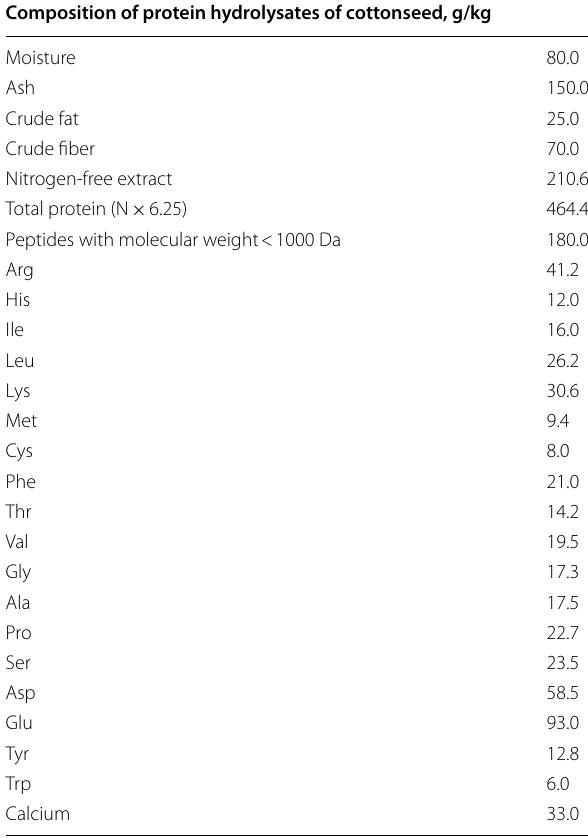
Table 2 Analysis of the protein hydrolysates of cottonseed Composition of protein hydrolysates of cottonseed, g/kg